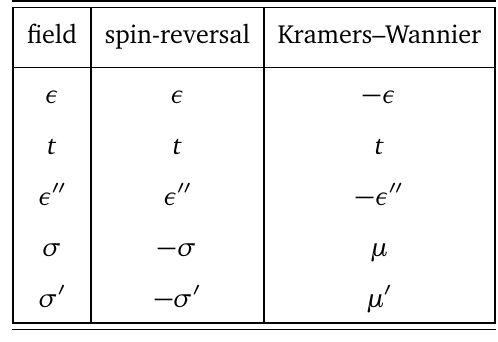
Table 3.5: Discrete symmetries of